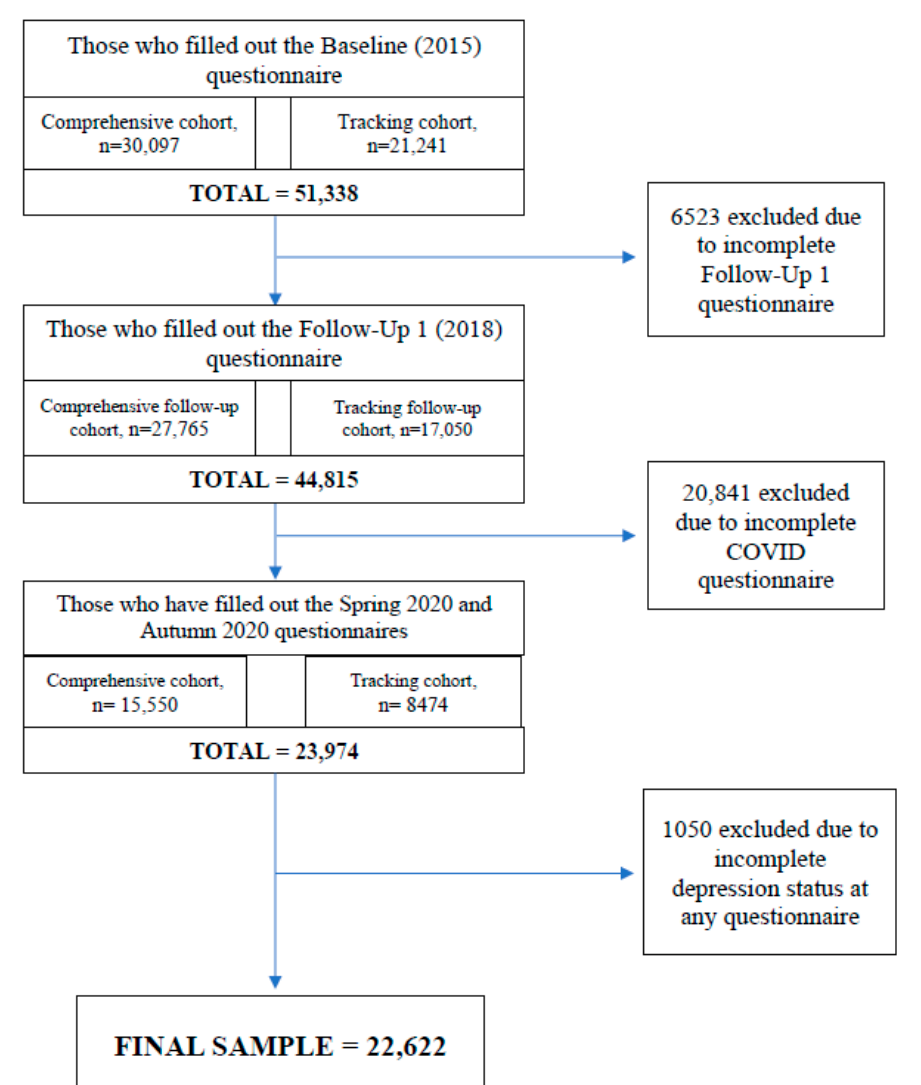
Figure 1. Study flowchart of CLSA participants used in this study.